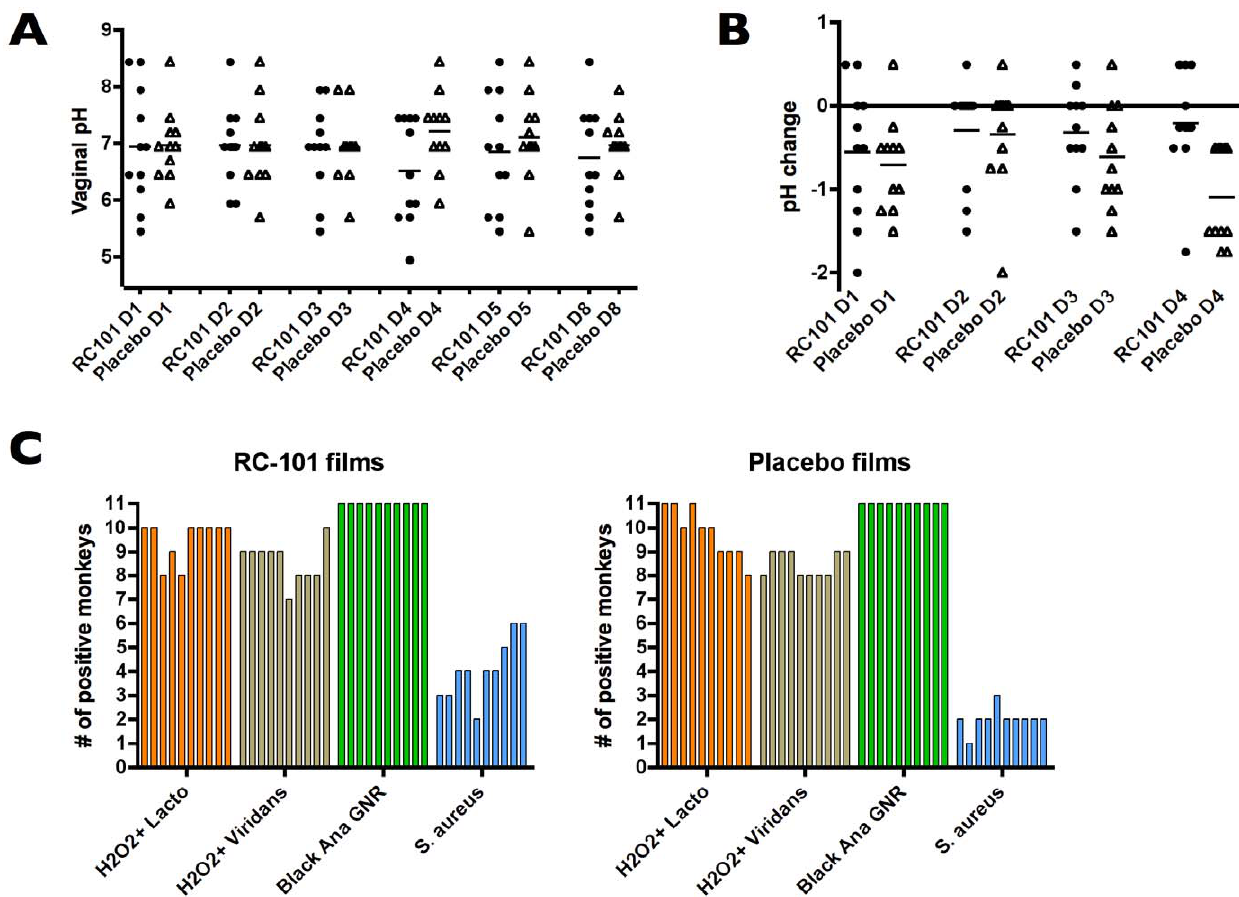
Figure 4. RC-101 films do not alter vaginal pH or microbiological profile of the cervicovagina. ( A ) Vaginal pH was measured prior to film instillation at days 1-4 (D1-D4) and at followup (D5 and D8). Each measurement represents one experimental condition in a pigtailed macaque. Horizontal lines represent the mean value for all 11 replicates. No differences were observed between monkeys that were receiving RC-101 films or placebo films. ( B ) represents the difference in vaginal pH between the time zero condition and 30 minutes after film instillation for each day films were applied (D1–D4). Horizontal lines represent the mean value for all 11 replicates. A significant difference was observed at Day 4 ( P =0.003), with the placebo films inducing a greater change in vaginal pH than the RC-101 films. ( C ) Four (of twenty) microbes are presented for both RC-101 films and placebo films. For each microbe, there are 10 vertical bars, representing the number of replicates (from a total of 11) that were positive for the microbe indicated. The ten bars for each microbe signify the following from left to right: Day 1 (D1) time zero (t0), D1, time 30 min (t30), D2 t0, D2 t30, D3 t0, D3 t30, D4 t0, D4 t30, D5 and D8.